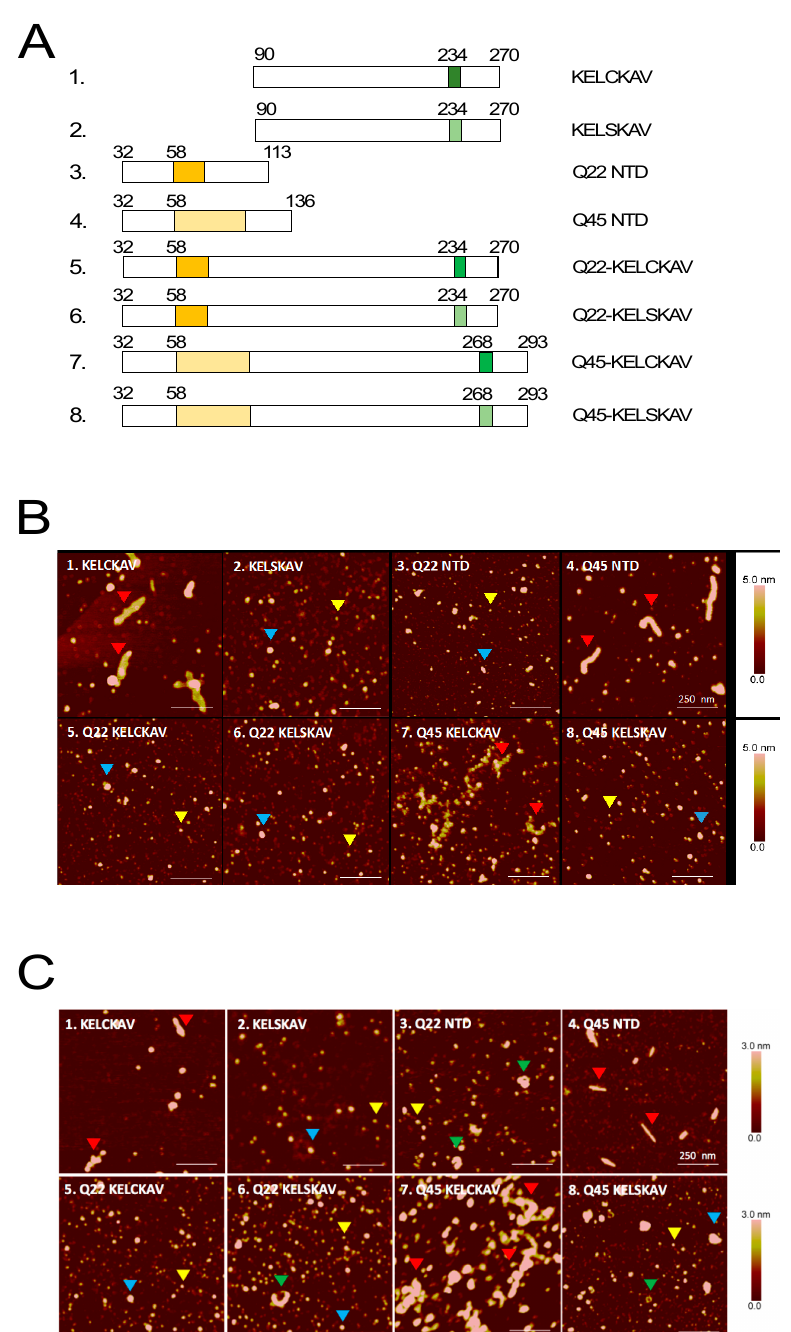
Figure 4. Morphology of Androgen Receptor ‐ Amino ‐ Terminal Domain (AR ‐ NTD) oligomers. ( A ) Schematic representation of amino terminal domain (AR ‐ NTD) peptides covering the polyQ stretch (Q22 and Q45) stretch and the KELCKAVSVSM sequence (in dark green) or with the cysteine mutation KEL S KAVSVSM (light green). ( B ) Glutathione S ‐ Transferase (GST) tagged AR ‐ NTD or ( C ) untagged AR ‐ NTD proteins were incubated for 18 h at 37 °C to initiate the aggregation process before spotting on mica for atomic force microscopy (AFM) measurements. Blue and yellow arrowheads refer to smaller and larger globular oligomers (SGOs and LGOs); green arrowheads refer to annular oligomers and red arrow heads to fibrillar oligomers.